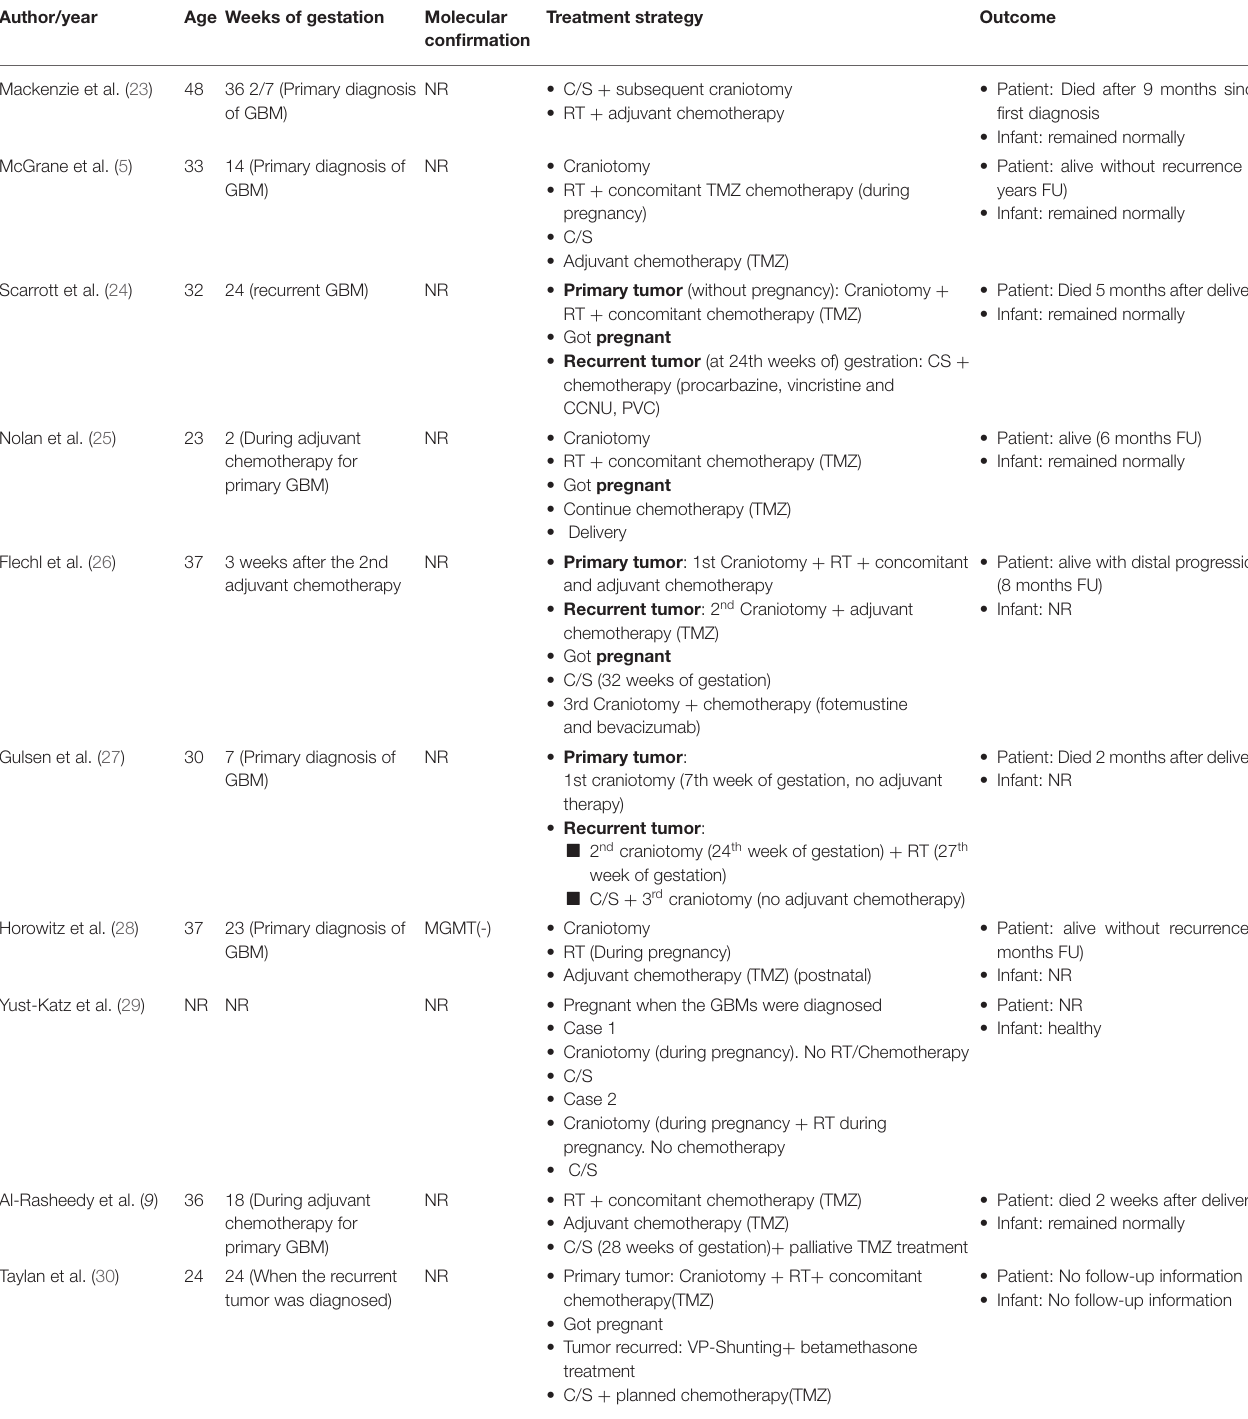
TABLE 1 | Defined cases of GBM in pregnancy published in the